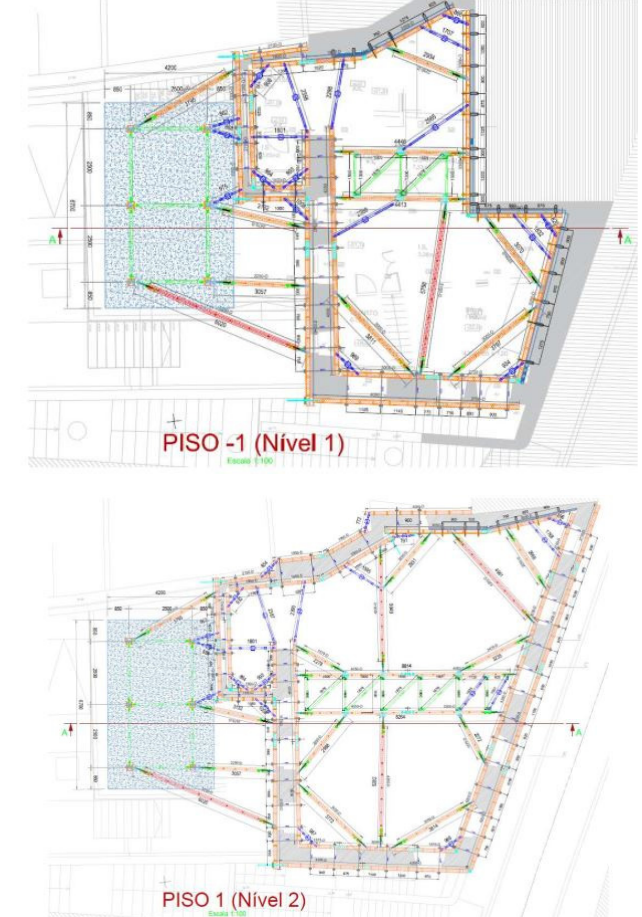
Figure 3. CAD drawings of the project.